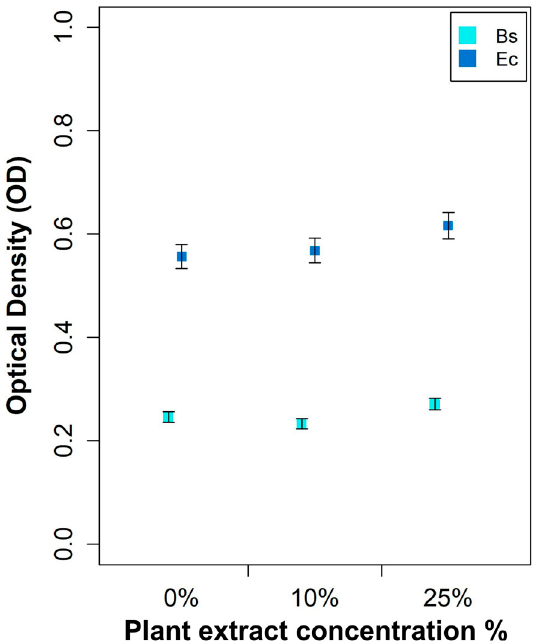
Figure 7. Representation of the dose response effect of Arbutus unedo leaf extract at two different concentrations against B. subtilis (Bs) and E. coli (Ec). No significant differences in optical density were detected within each species with respect to the null concentration.